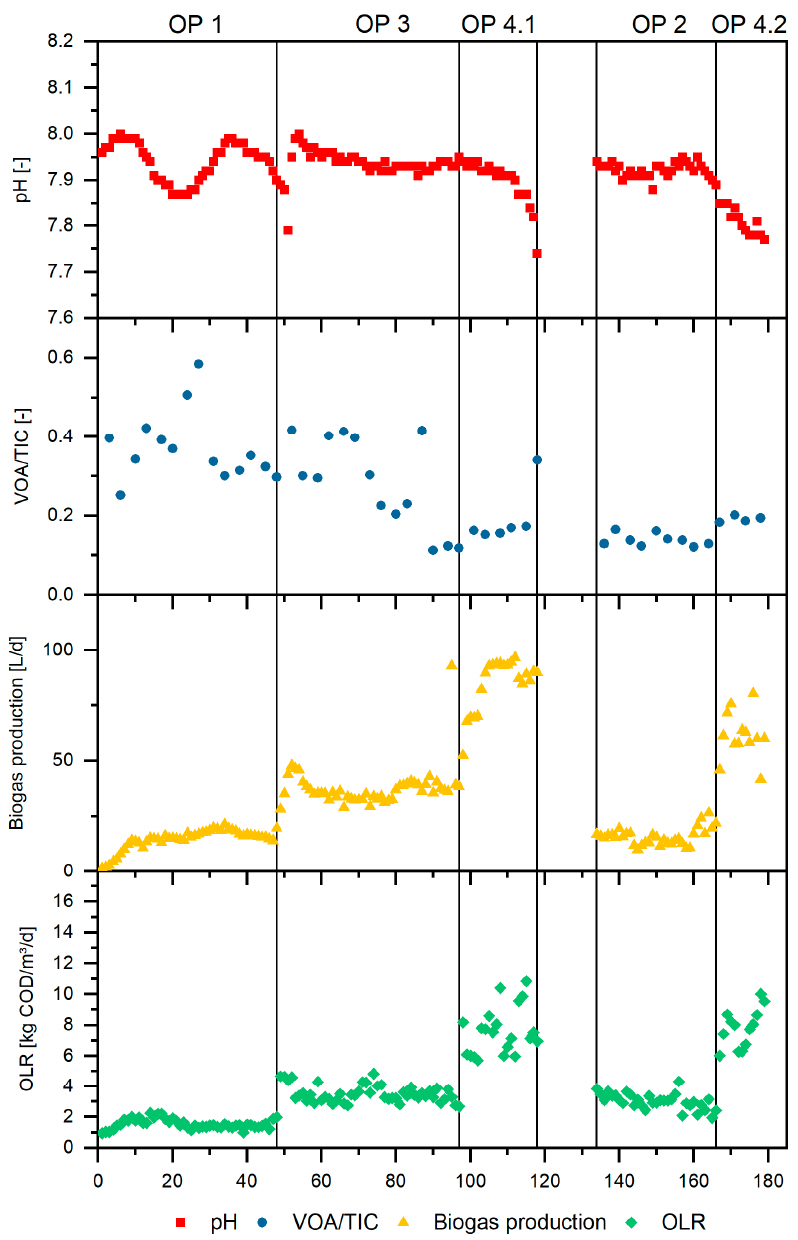
Figure 3. pH, VOA/TIC, biogas production, and COD-specific OLR of R2 over the experimental